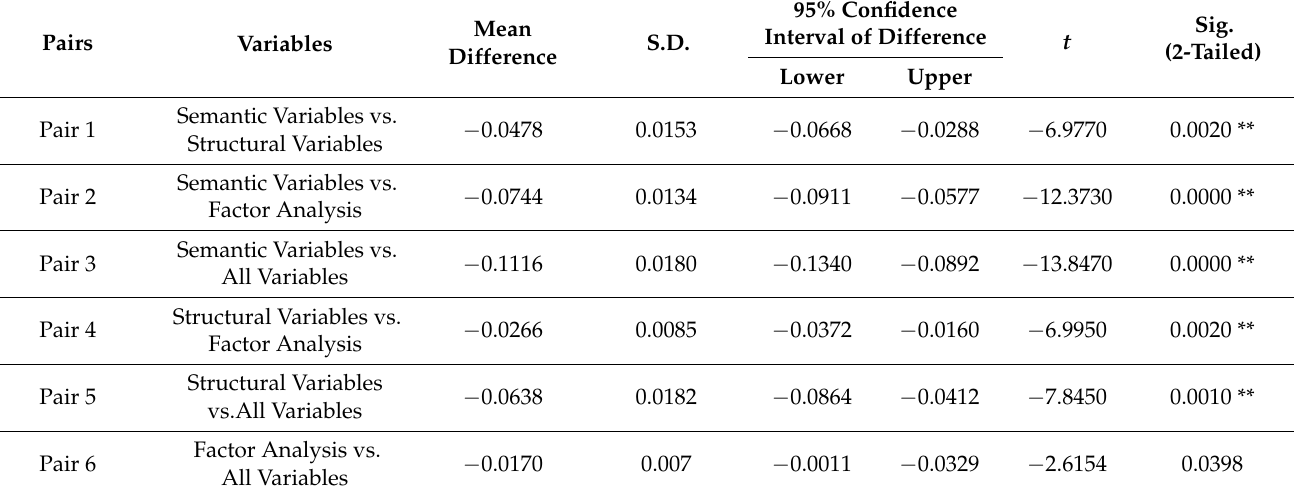
Table 9. Paired-sample t -test of differences in